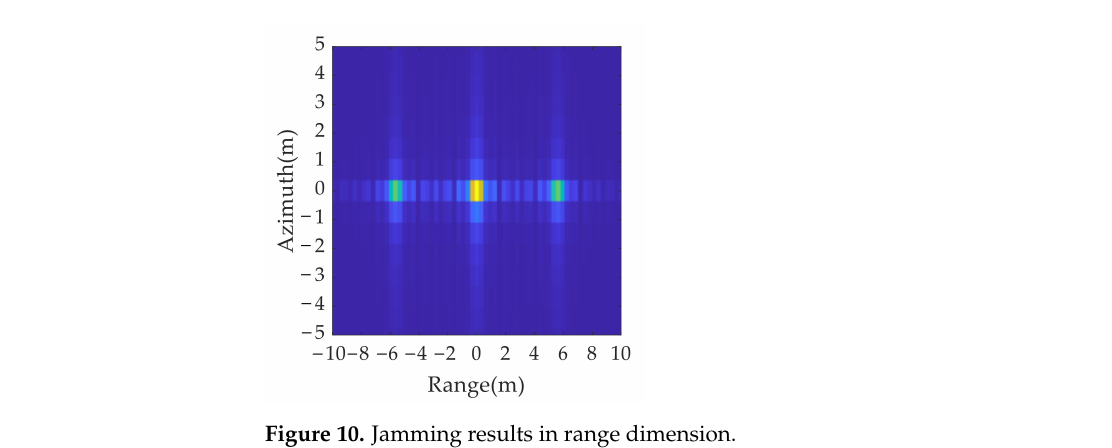
Figure 10. Jamming results in range dimension.